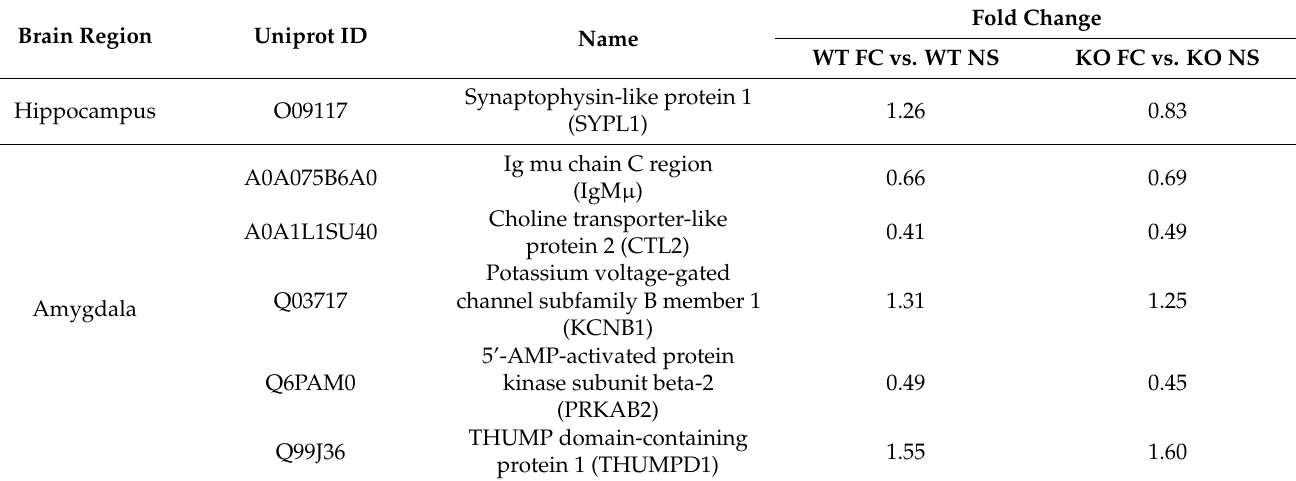
Table 1. Proteins that were both regulated in WT and KO after fear